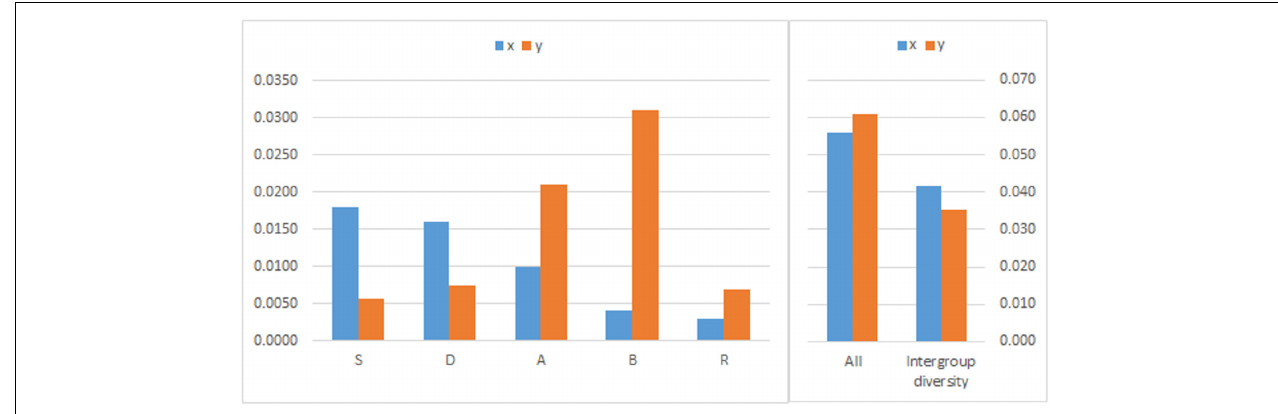
FIGURE 2 | The divergence of the promoters of Glu-1 genes in wheat. Analyses were conducted using the Maximum Composite Likelihood model. All positions containing gaps and missing data were eliminated. Evolutionary analyses were conducted in